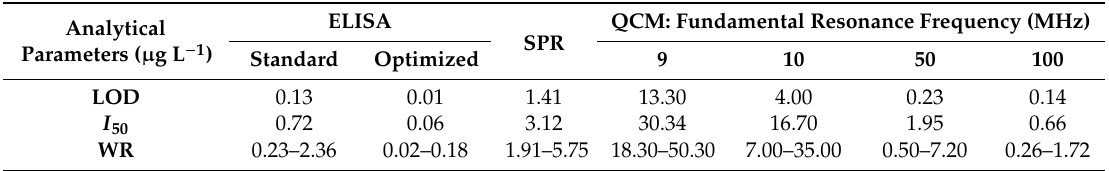
Table 2. Comparison of analytical performance for carbaryl detection by ELISA, SPR and QCMs of variable frequencies, adapted with permission from